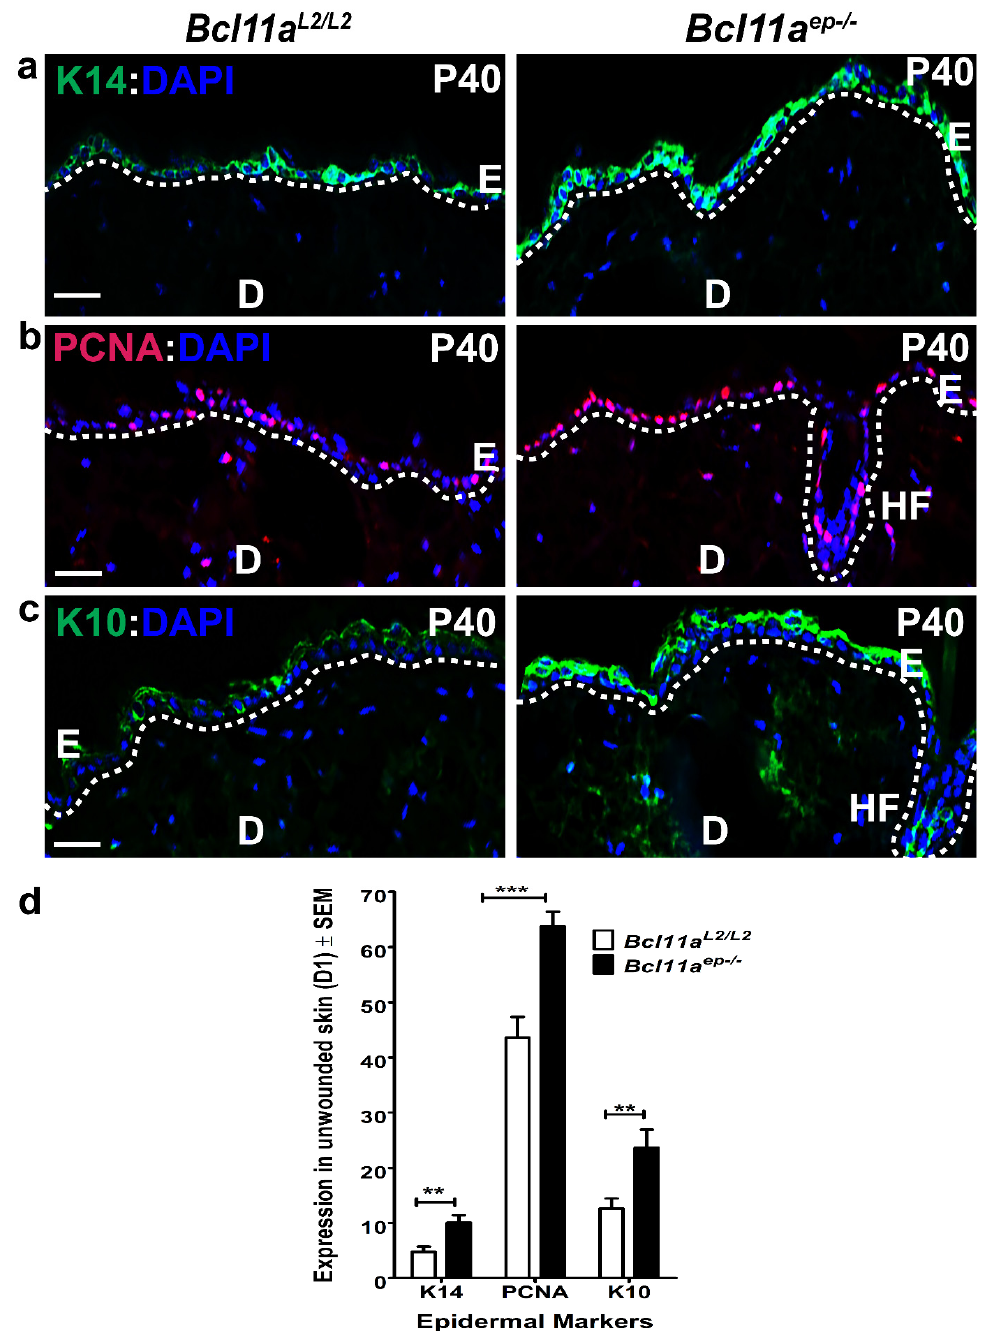
Figure 2. Conditional ablation of Bcl11a in adult epidermis leads to enhanced expression of key epidermal proliferation and differentiation markers in normal skin. ( a – c ) IHC of P40 dorsal skin sections with basal keratinocyte marker K14 (green), active proliferation marker PCNA (red) and early differentiation marker K10 (green) in Bcl11a L2/L2 versus Bcl11a ep − / − mice. All 5 µ m-thick paraffin sections were counterstained with DAPI (blue). White dotted lines separate E from D and outline the HFs. D, dermis; E, epidermis; HF, Hair follicle. Scale bar = 50 µ m. ( d ) Bar graph quantification of baseline expression of epidermal markers (K14, PCNA, K10) in P40 Bcl11a L2/L2 versus Bcl11a ep − / − skin. N = 2, where N represents the number of animals of each genotype ( Bcl11a L2/L2 or Bcl11a ep − / − ) being involved in the study. 10–12 field of views (FOVs) captured per sample per genotype to determine the statistical significance. ** p < 0.01, *** p <